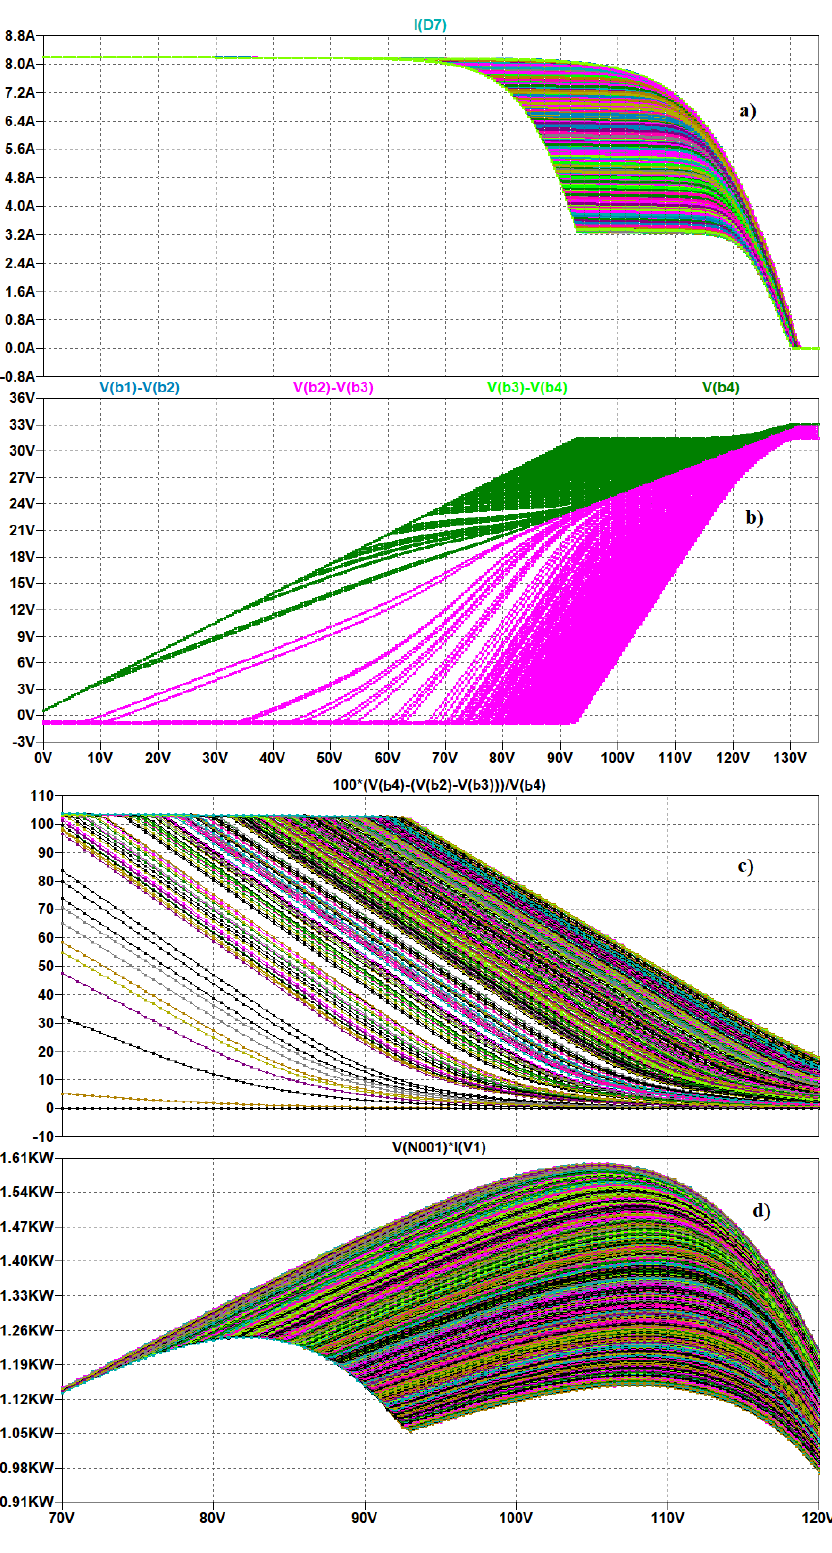
Figure A1. Optical homogeneous degradation faults. This figure shows four charts as following: ( a ) the current of the affected string versus the operation voltage of the array, ( b ) the differential voltage for all the modules in the affected string, ( c ) the relative percentage difference versus the operating voltage of the array, ( d ) peak behavior of output power in the